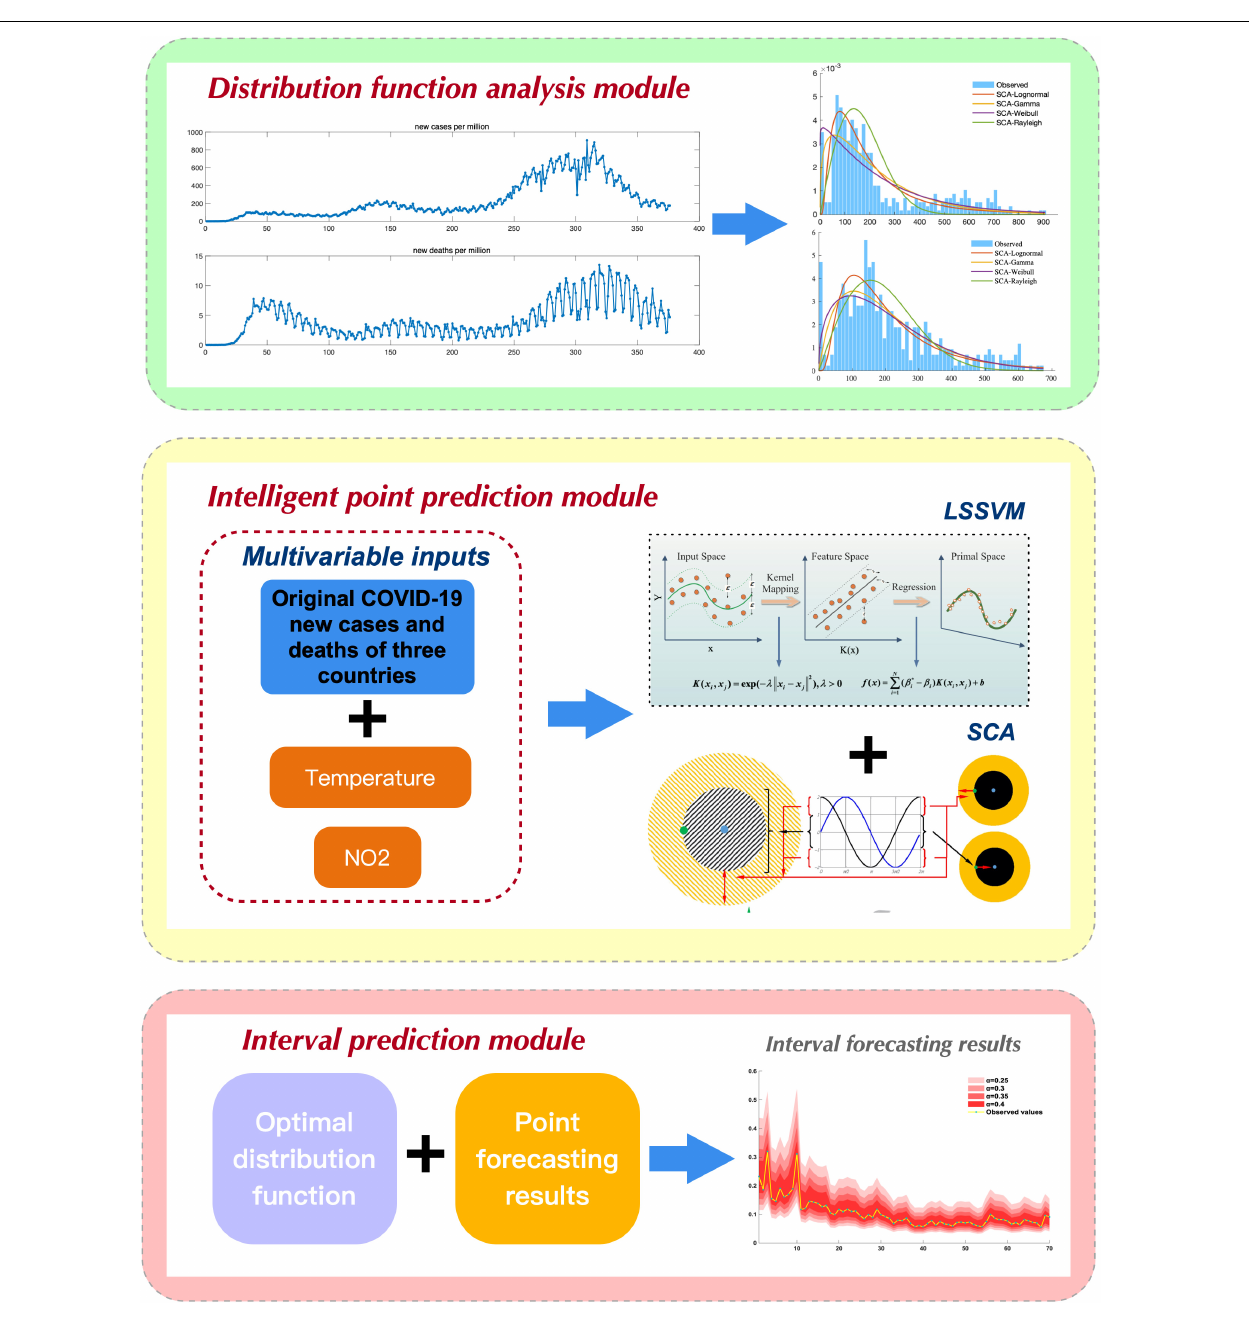
FIGURE 1 | The main procedure of the proposed